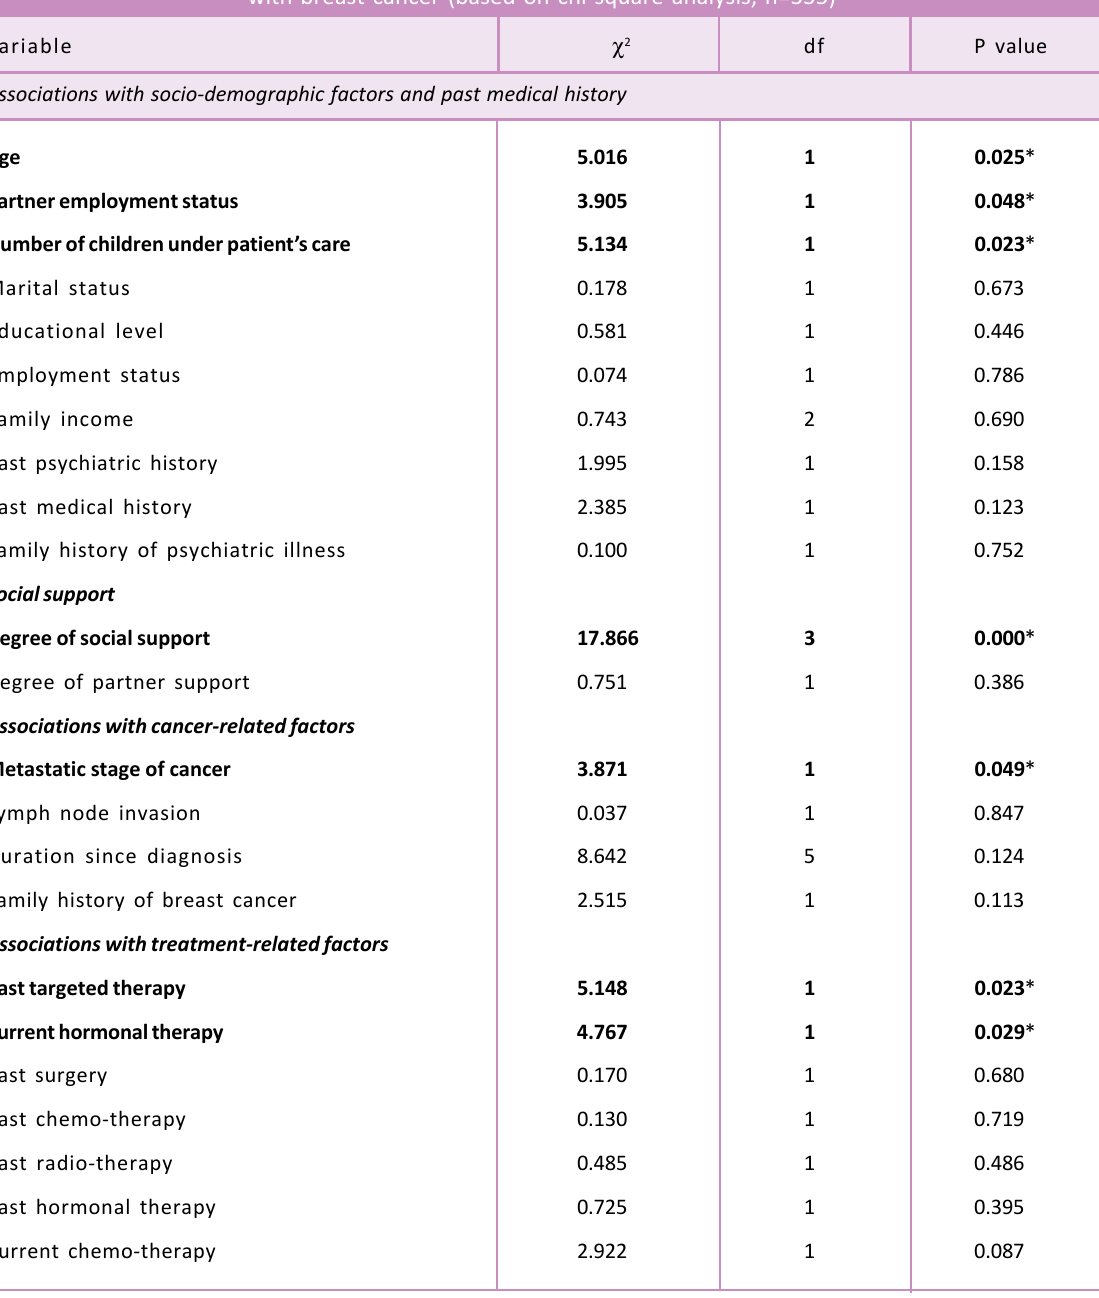
Table 1. Associations between variables of interest and the presence of depression in women with breast cancer (based on chi square analysis,